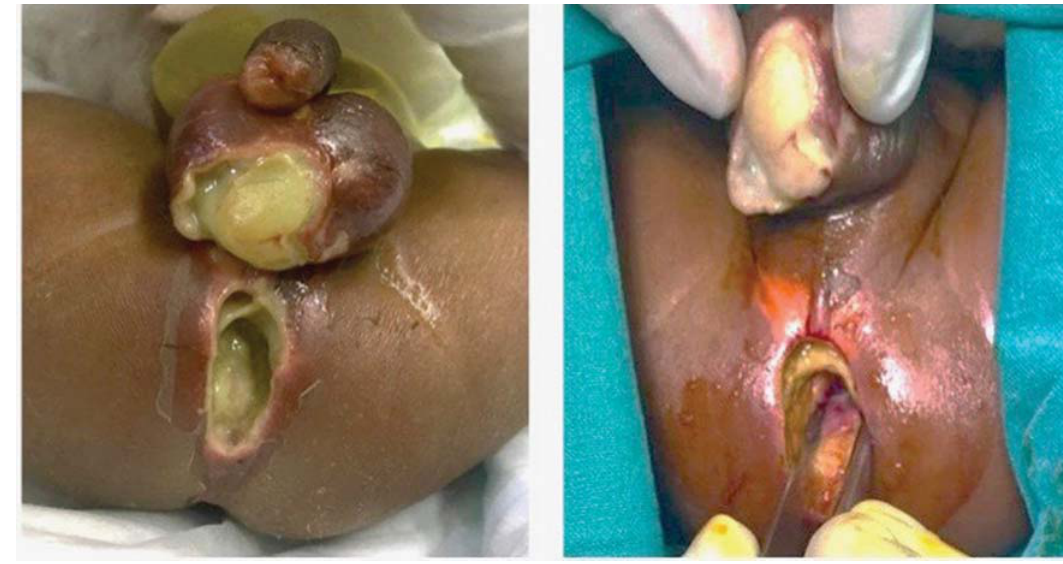
Fig. 5 Case 2. Features of the perineum and scrotum 24 hours after the perforation occurred with macroscopic necrotizing